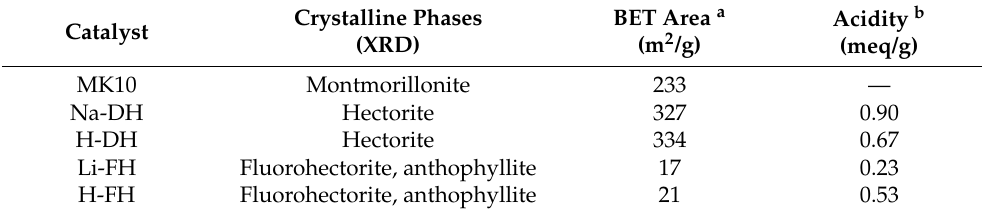
Table 3. Characterization of the